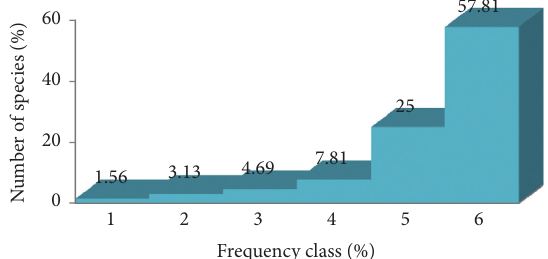
Figure 4: Woody plant species frequency classes’ distribution of Kafta Sheraro National Park (KSNP). (1) 65.1–80%, (2) 50.1–65%, (3) 35.1–50%, (4) 20.1–35%, (5) 5.1–20%, and (6) ≤